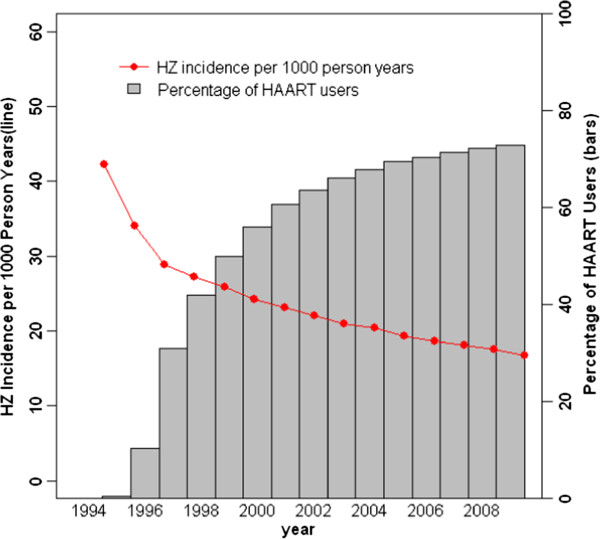
Trends in percentage of HAART users and herpes zoster Incidence among HIV-infected women in the WIHS.